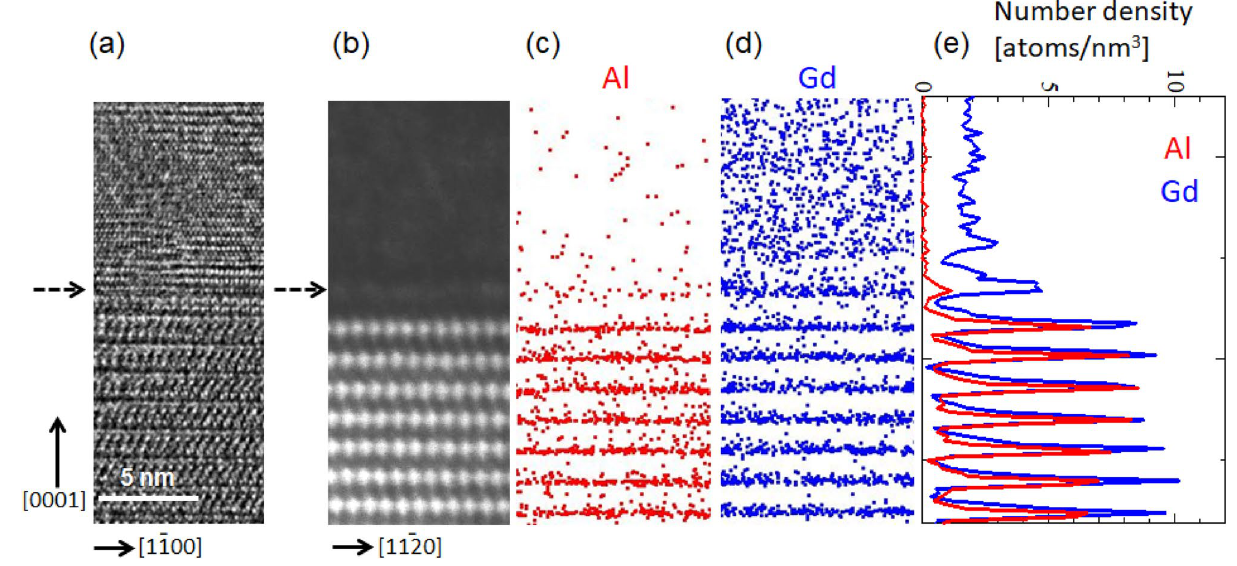
) 0] direction. ( b ) HAADF-STEM image Figure 2. ( a ) High-resolution TEM image taken along the [11 2 ( − ) 00] direction. ( c , d ) 15-nm-thick sliced APT maps for Al and Gd in the same region as taken along the [1 1 ( − the TEM/STEM images. ( e ) Concentration profile along the [0001] direction around the interface region of the LPSO/OD and α-Mg phases. Software: ( a , b ) Gatan Microscopy Suite (GMS), Ver. 2.30.542.0, https